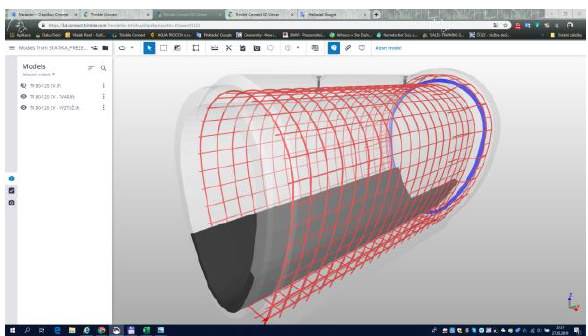
Figure 4. 3D reinforcement in CDE